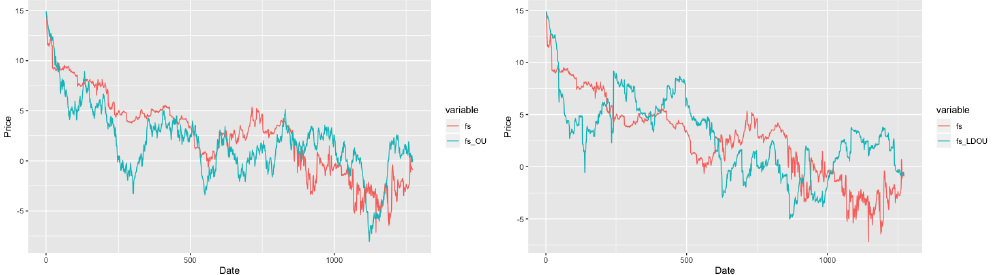
Figure 4. Simulation Result of OU and LDOU model on fuel-switching data.